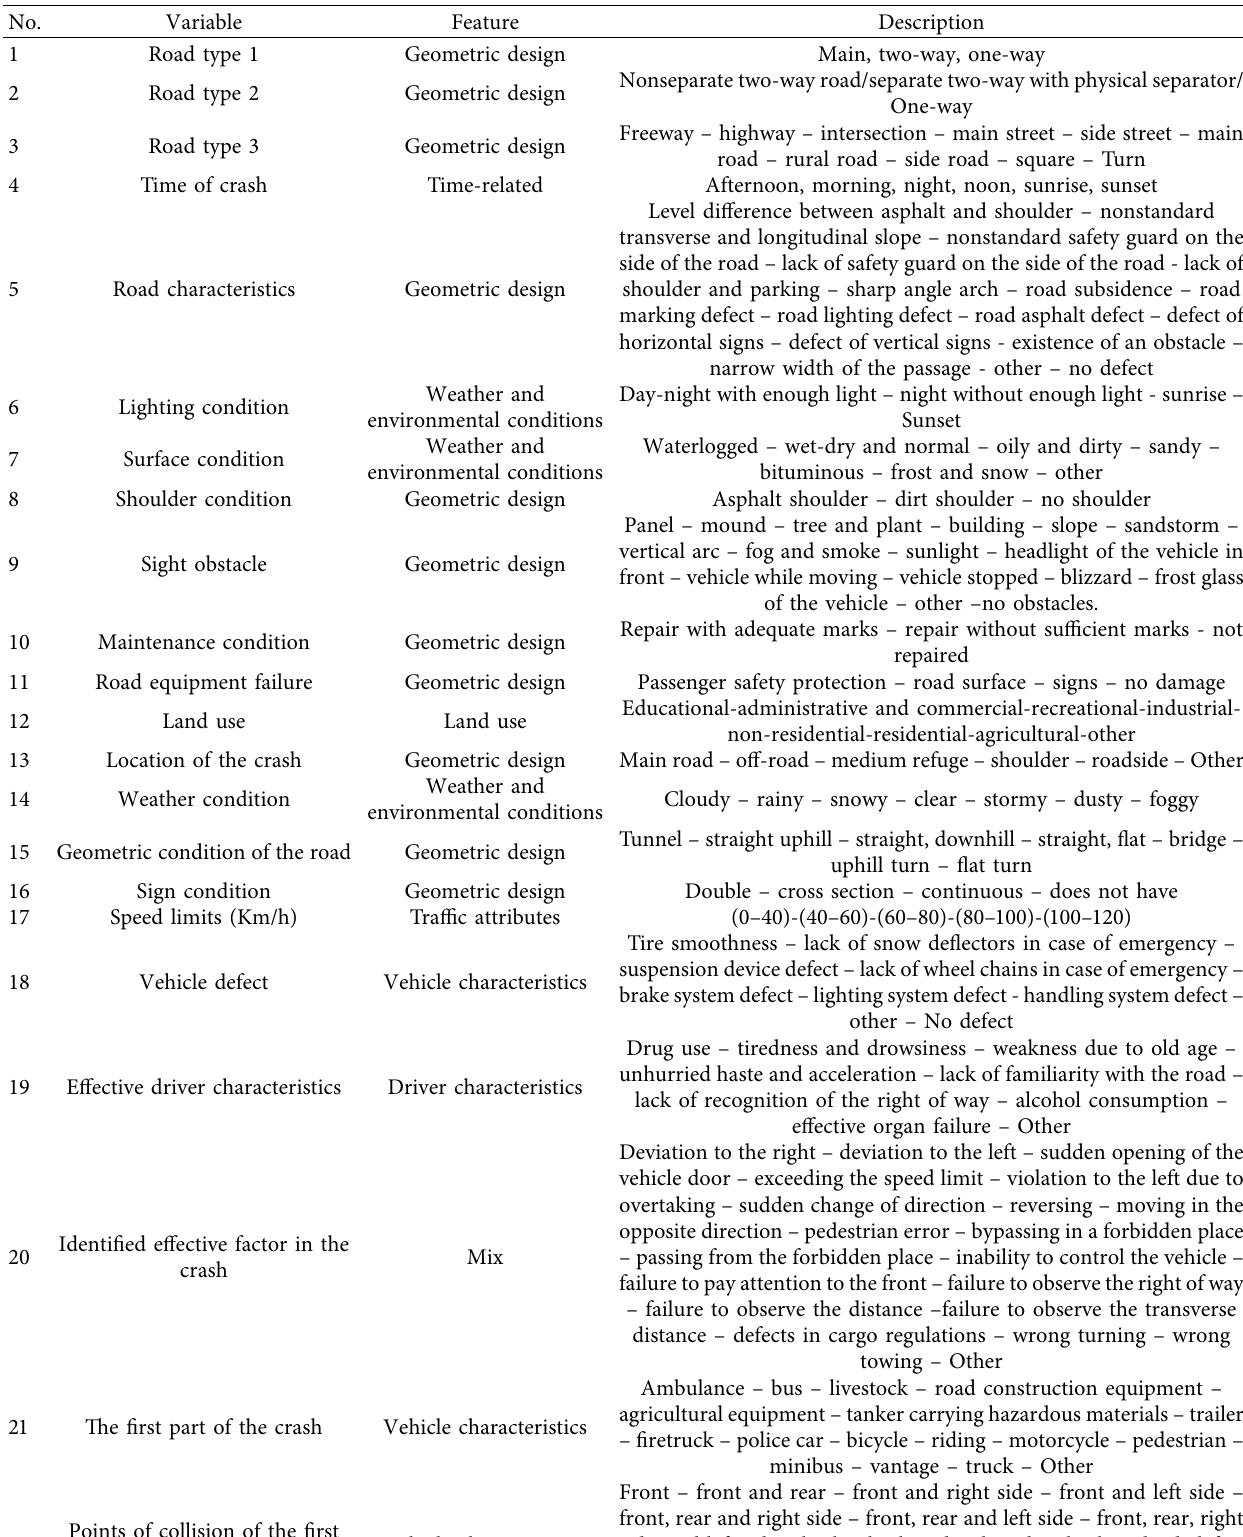
Table 2: Independent variables in the data